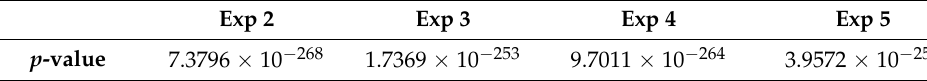
Table 6. DBN models’ lowest errors statistical significance test.